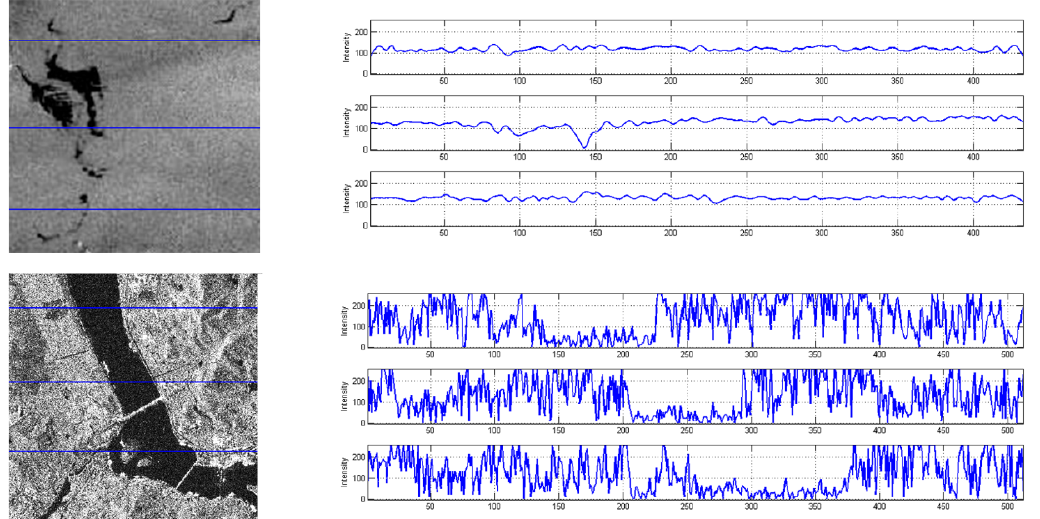
Figure 5. Two different real SAR images and the corresponding change in the intensity. The abscissa axis in the right subfigure indicates the image width of the left subfigure, and the axis of ordinates in the right subfigure indicates the intensity value of each pixel along the corresponding blue strokes of the left SAR image.